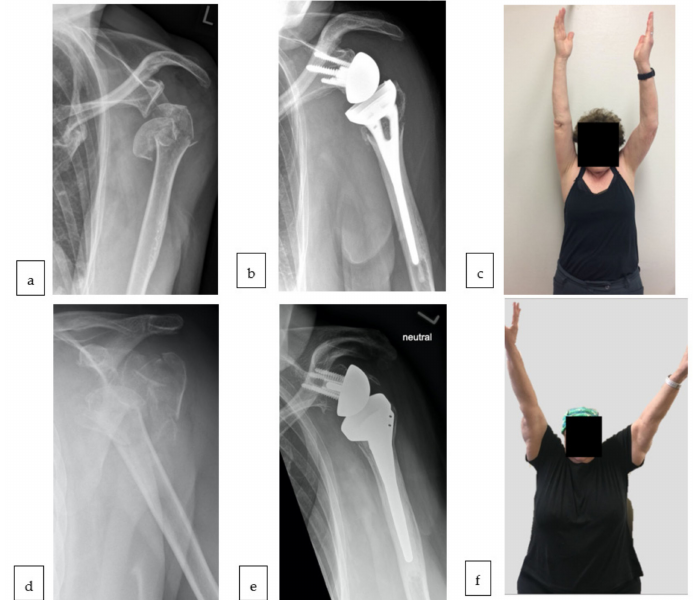
Figure 1. The figure show a 72-year-old female patient with a head split proximal humerus fractures (PHF) ( a ) treated with a fracture specific stem ( b ) four years after implantation ( c ). The figure shows a 70-year-old female patient with a four-part fracture ( d ) treated with conventional stem ( e ) five years after implantation ( f